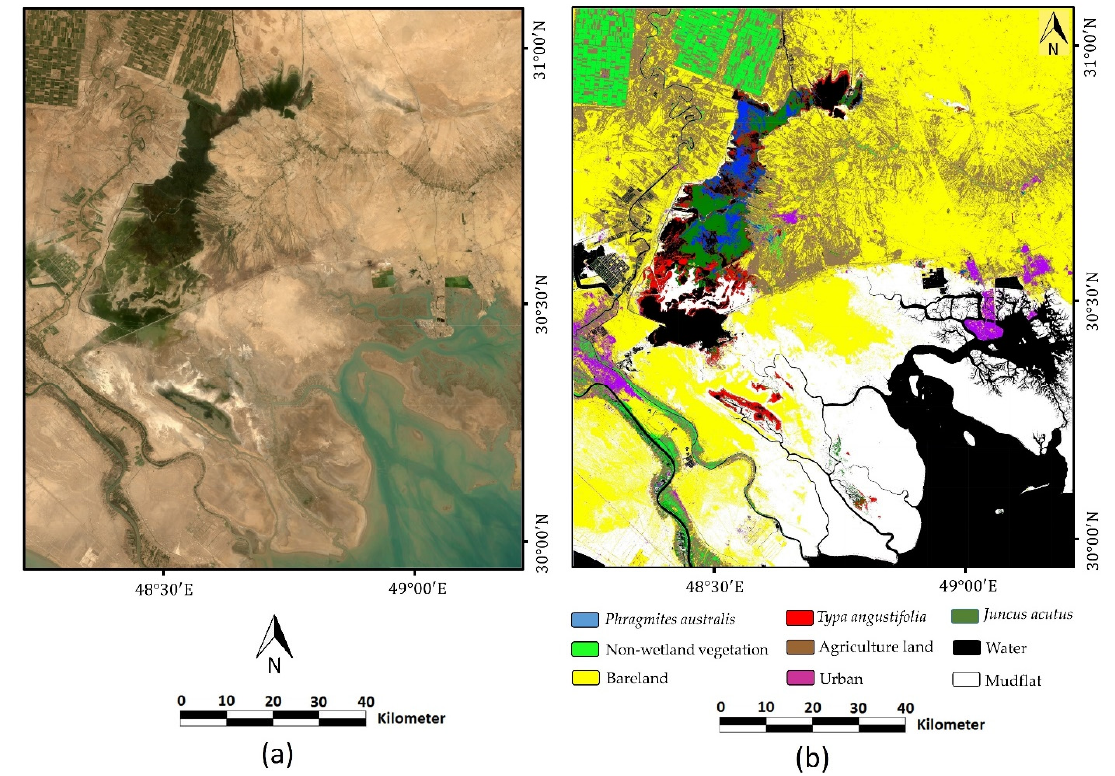
Figure A3. Growing season mosaic of the target year 2018 ( a ) and wetland map of target year 2018 using migrated samples ( b ).